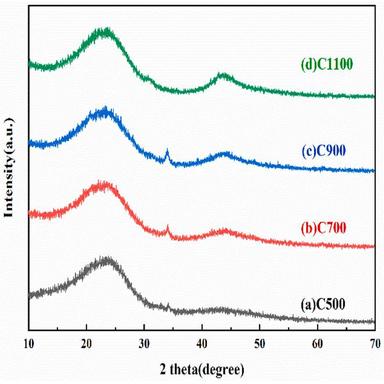
XRD patterns of (a) C500, (b) C700, (c) C900, (d) C1100.